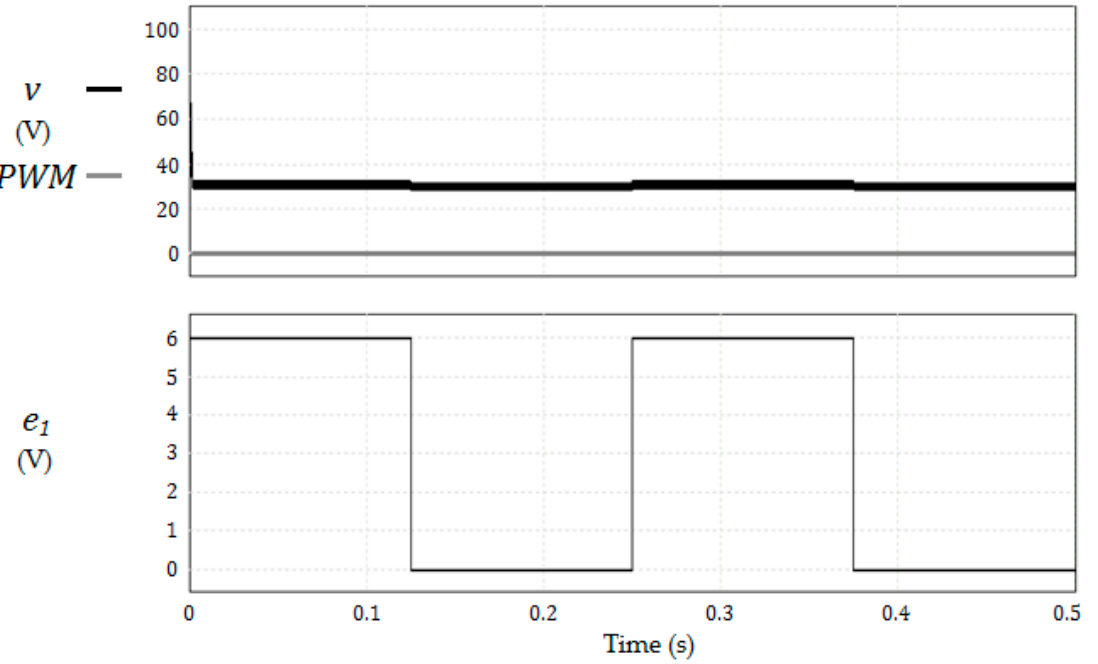
Figure 16. Simulation behavior for PI closed-loop, with short-circuit failure events in e 1 . Output voltage, PWM, and e 1 are shown from top to bottom.